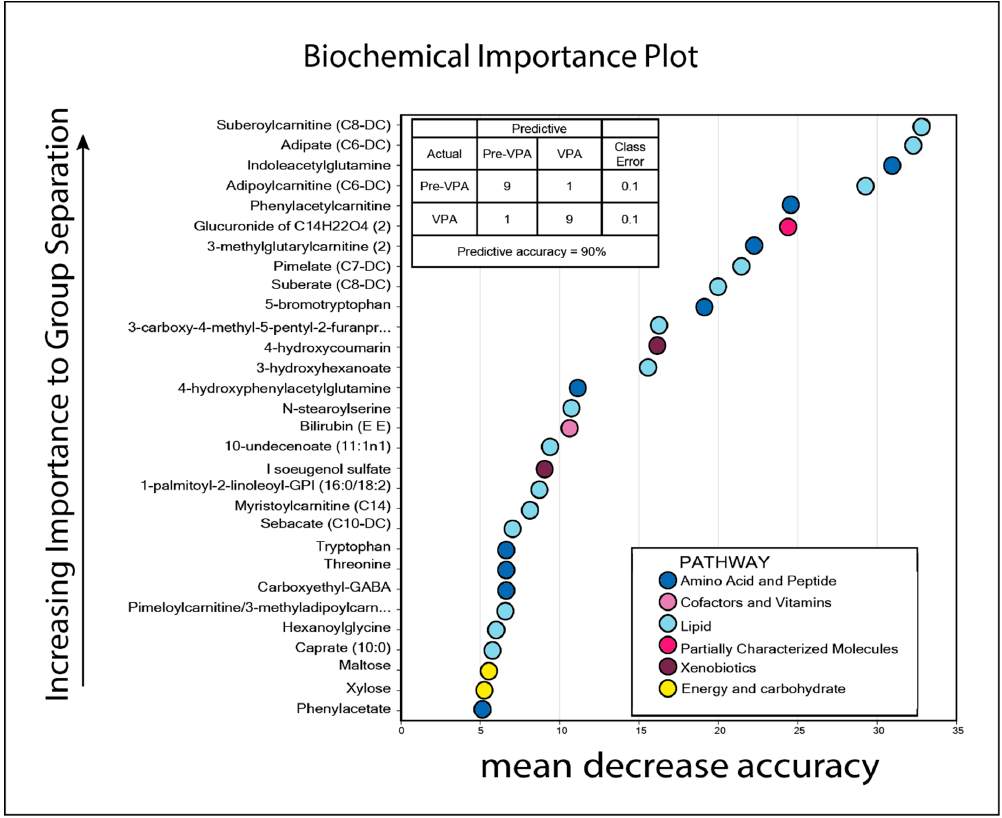
Figure 6. The effect of 7-day valproic acid (VPA) monotherapy on the serum metabolomic profiles for ten patients (five responders and five non-responders). The random forest analysis was based on the identification of 886 metabolites in pretherapy samples and samples collected after seven days of valproic acid monotherapy. The analysis showed a predictive accuracy of 90% (see the insert table) after exclusion of the four valproic acid metabolites. The top-30 most important metabolites for separation of the two groups are shown in ranking order. Color codes indicate the classification of individual metabolites at the lower right part of the figure.